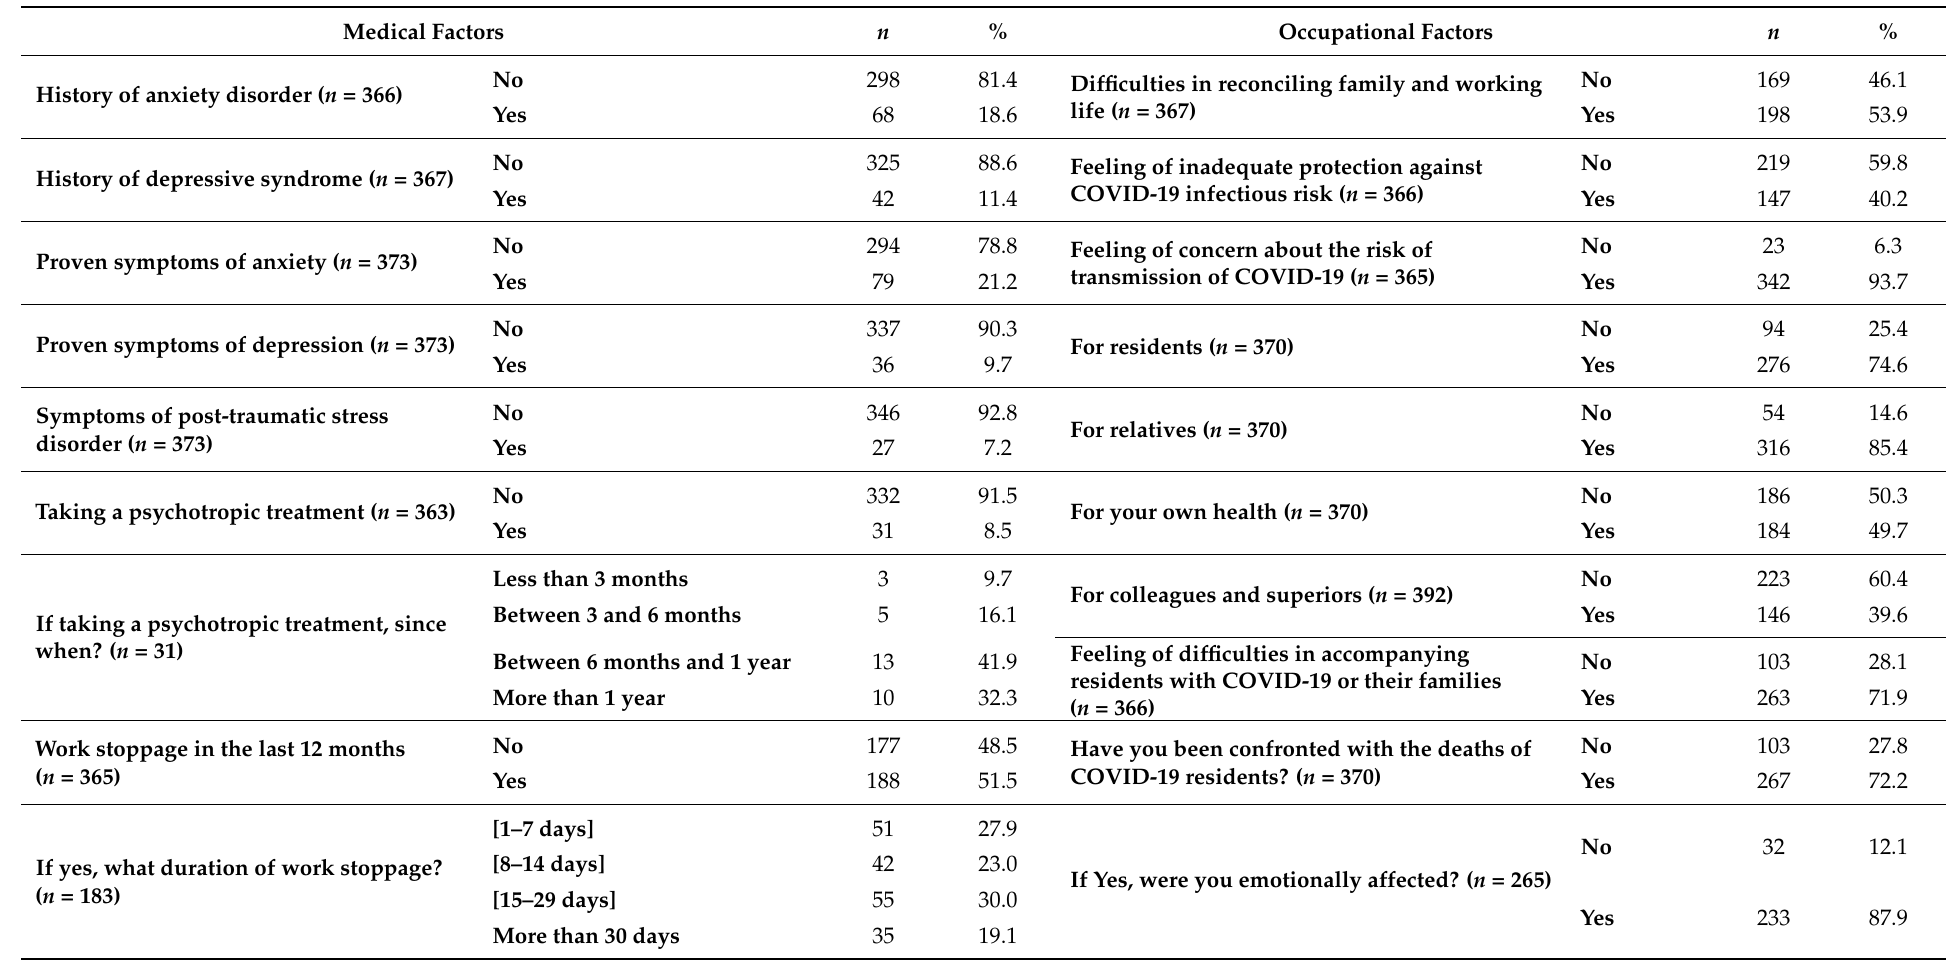
Table 1. Socio-occupational and medical